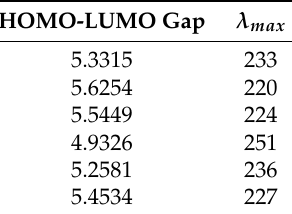
Table 1. HOMO and LUMO orbital energies as well as the HOMO–LUMO gap (in eV), and the maximum absorption wavelengths λ max (in nm) calculated with the MN12SX/Def2TZVP/H 2 O model chemistry. Molecule HOMO LUMO HOMO-LUMO Gap λ max Seragamide